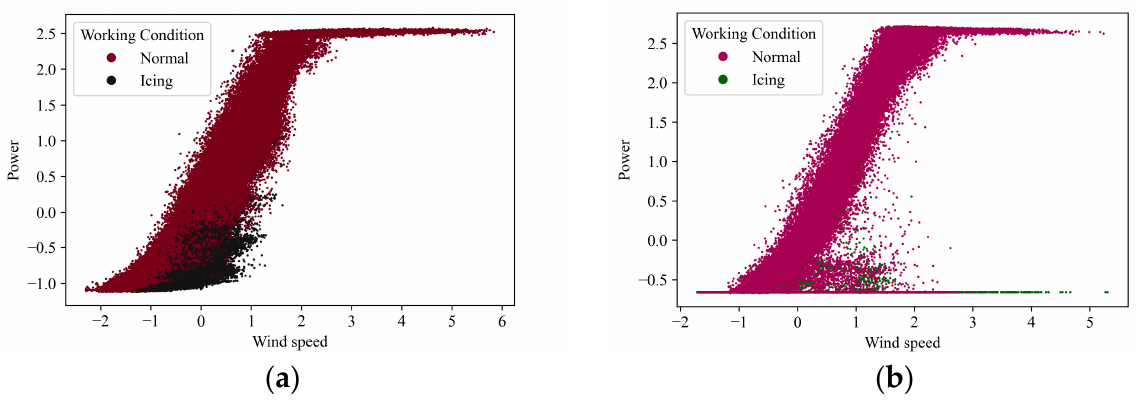
Figure 3. Wind-speed–power scatter plot for both data. ( a ) Data with high label reliability; ( b ) data with poor label reliability.